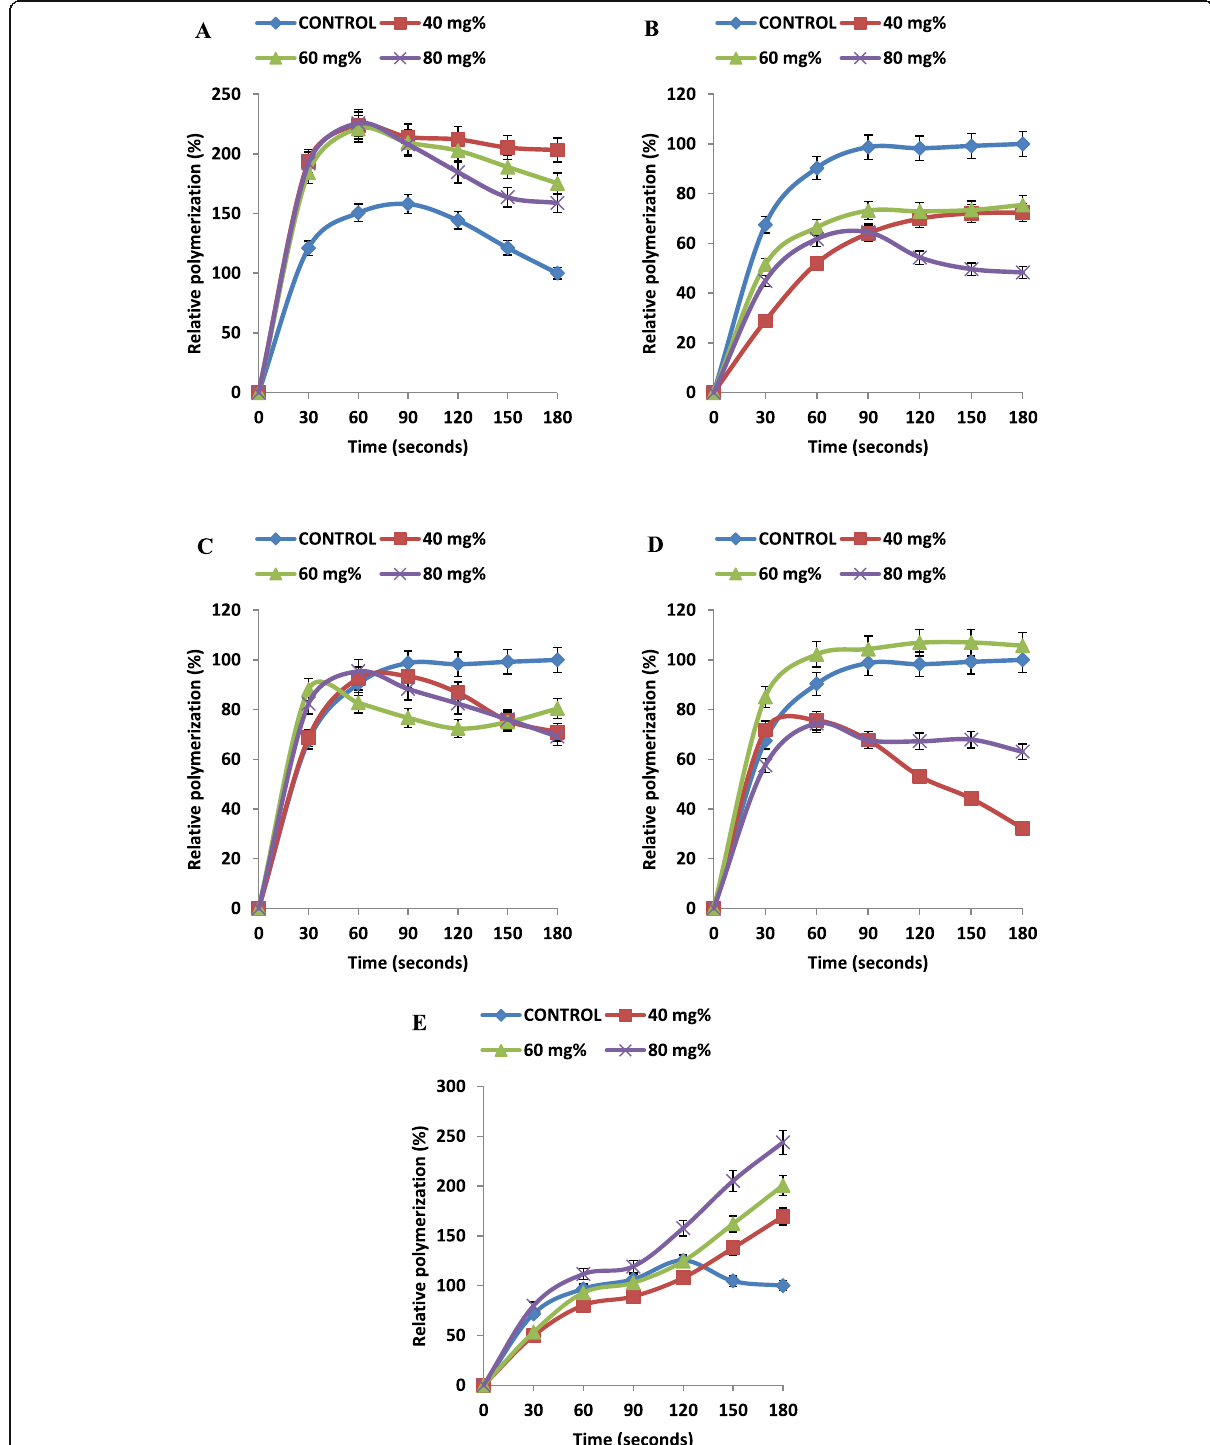
Fig. 2 Comparative levels of poly-dHbS-M of control sample and in the presence of fractionated leaf extracts of P . guajava. a Petroleum ether. b n -hexane. c Chloroform. d Ethylacetate. e Residual aqueous; mg% = mg/100